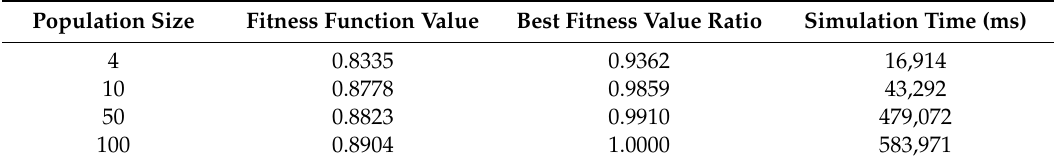
Table 2. Optimization results for di ff erent population